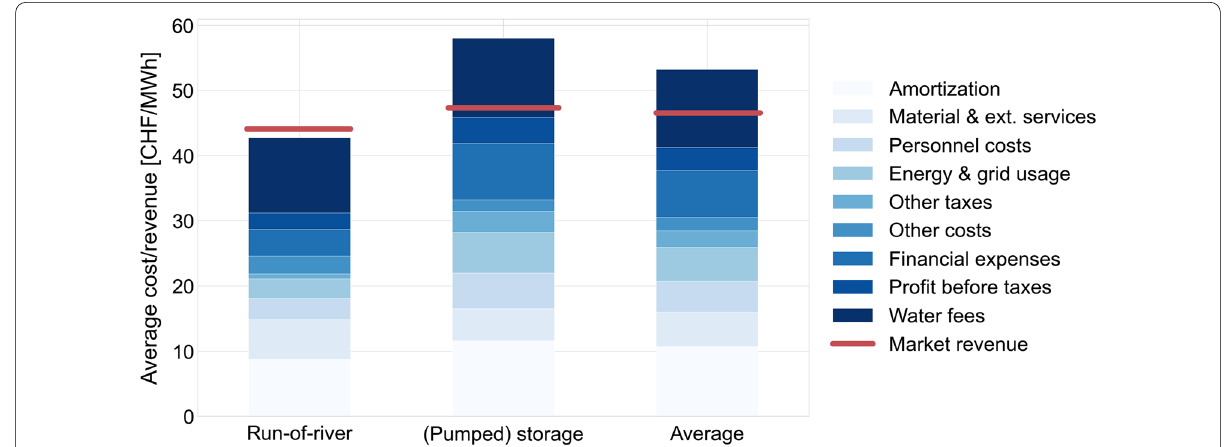
Fig. 1 Average production costs and revenues in 2015/16. Note : For data sources and construction, see Sect.